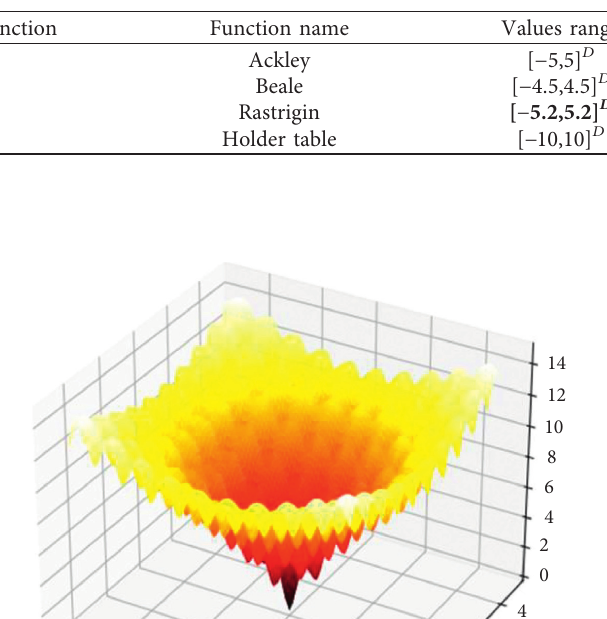
Table 1: Benchmark function.